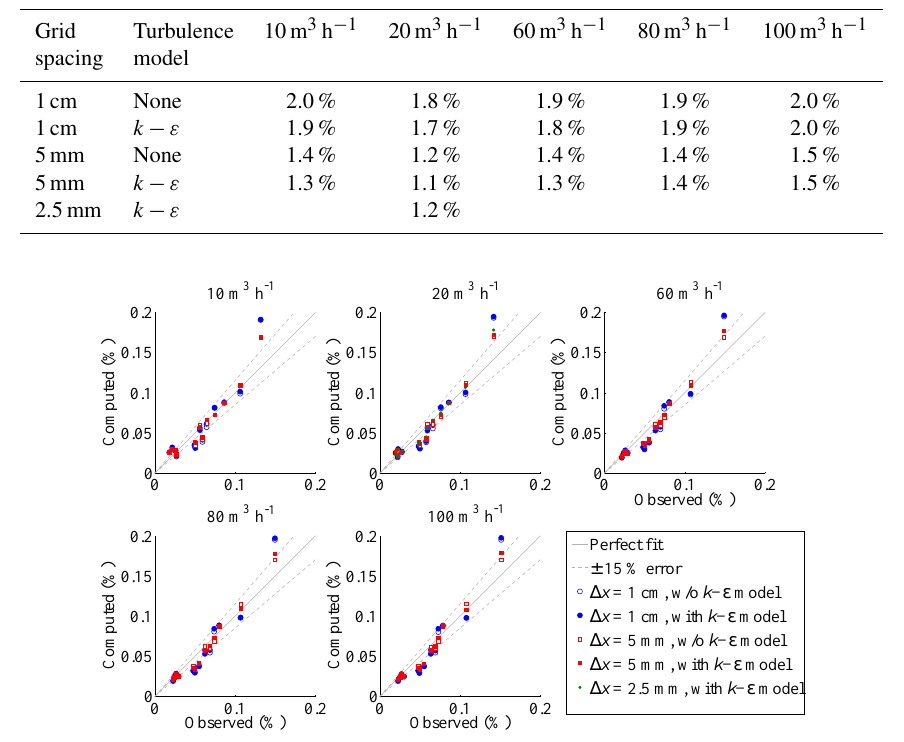
Table 3. Root mean square error of the outflow discharges in each street (expressed in percentage of the total inflow), as a function of the total inflow and the modelling characteristics.